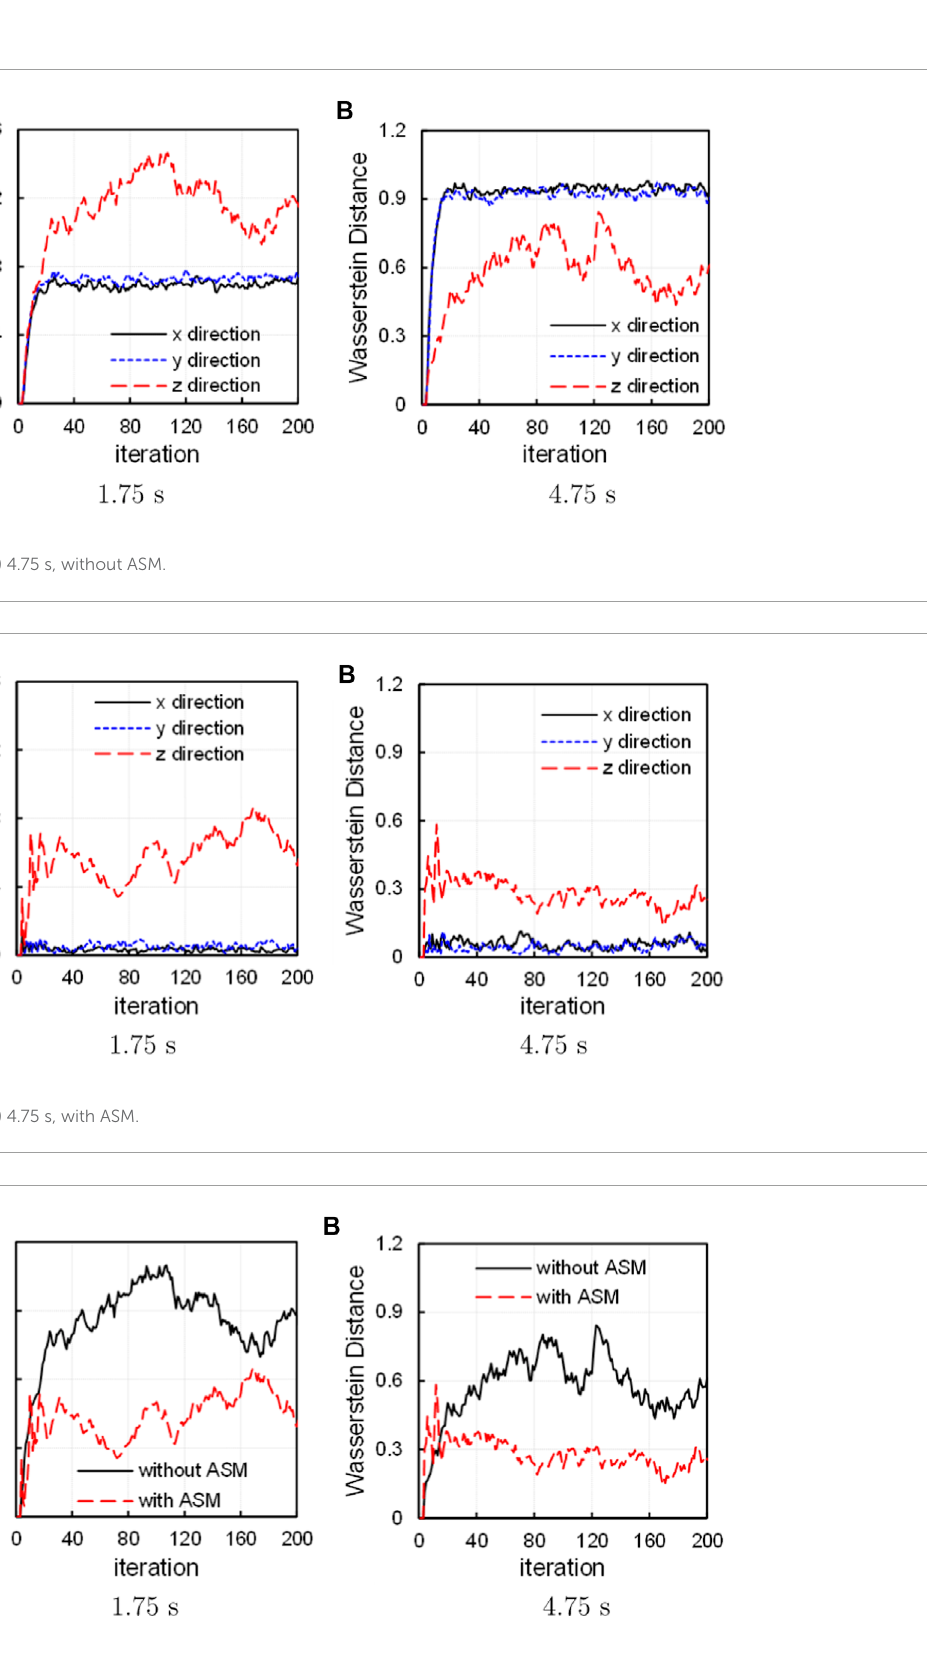
FIGURE 10 Comparison of Wasserstein distance curves in the z direction at (A) 1.75 s and (B) 4.75